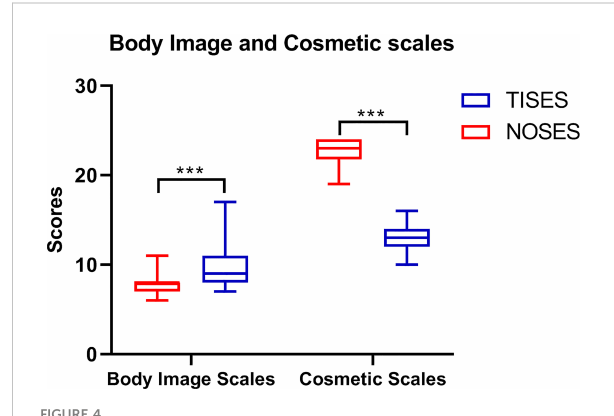
FIGURE 4 Comparison of Body Image Questionnaire (BIQ) in two groups. ***p <